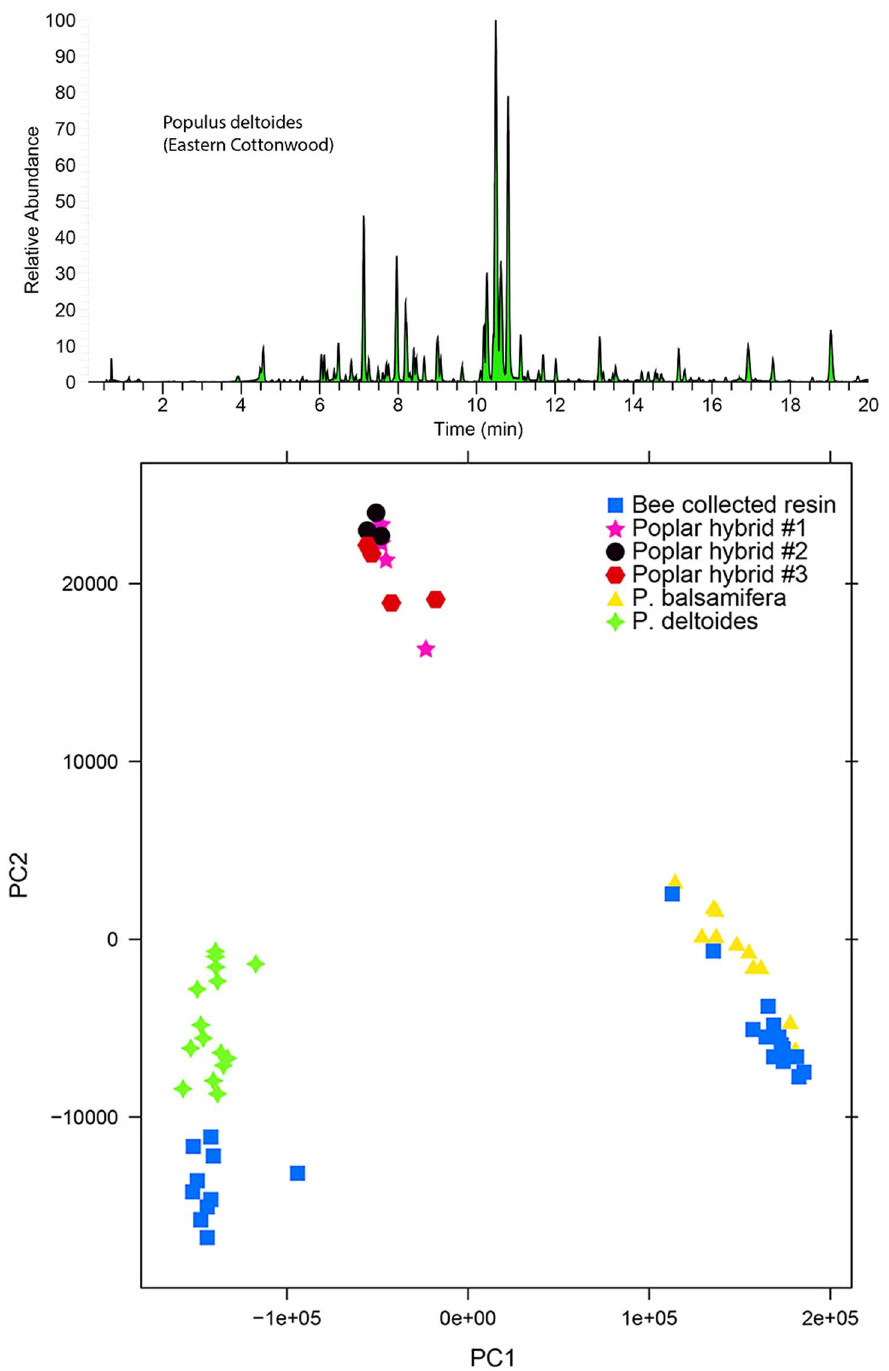
Figure 6. Honey bees collect resin from P.balsamifera and P.deltoides . (Top) Example of a P. deltoides resin metabolite ‘fingerprint’. (Bottom) PCA scores plot of resin ‘fingerprints’ from individual resin-producing plants and honey bee resin foragers. Points represent the spectral composition of a biological sample. Points that are closer together have more spectral peaks in common than with points that are farther apart. 54.35% of the total variation in the data set is shown. Hybrid poplars were sampled once in June, while P. deltoides (Eastern cottonwood) and P. balsamifera (balsam poplar) once in June and once in July. N=25 for resin from foraging bees, N=11 for P. balsamifera , N=16 for P. deltoides (9 from near Jamestown, ND), and N=5 for each poplar hybrid population.